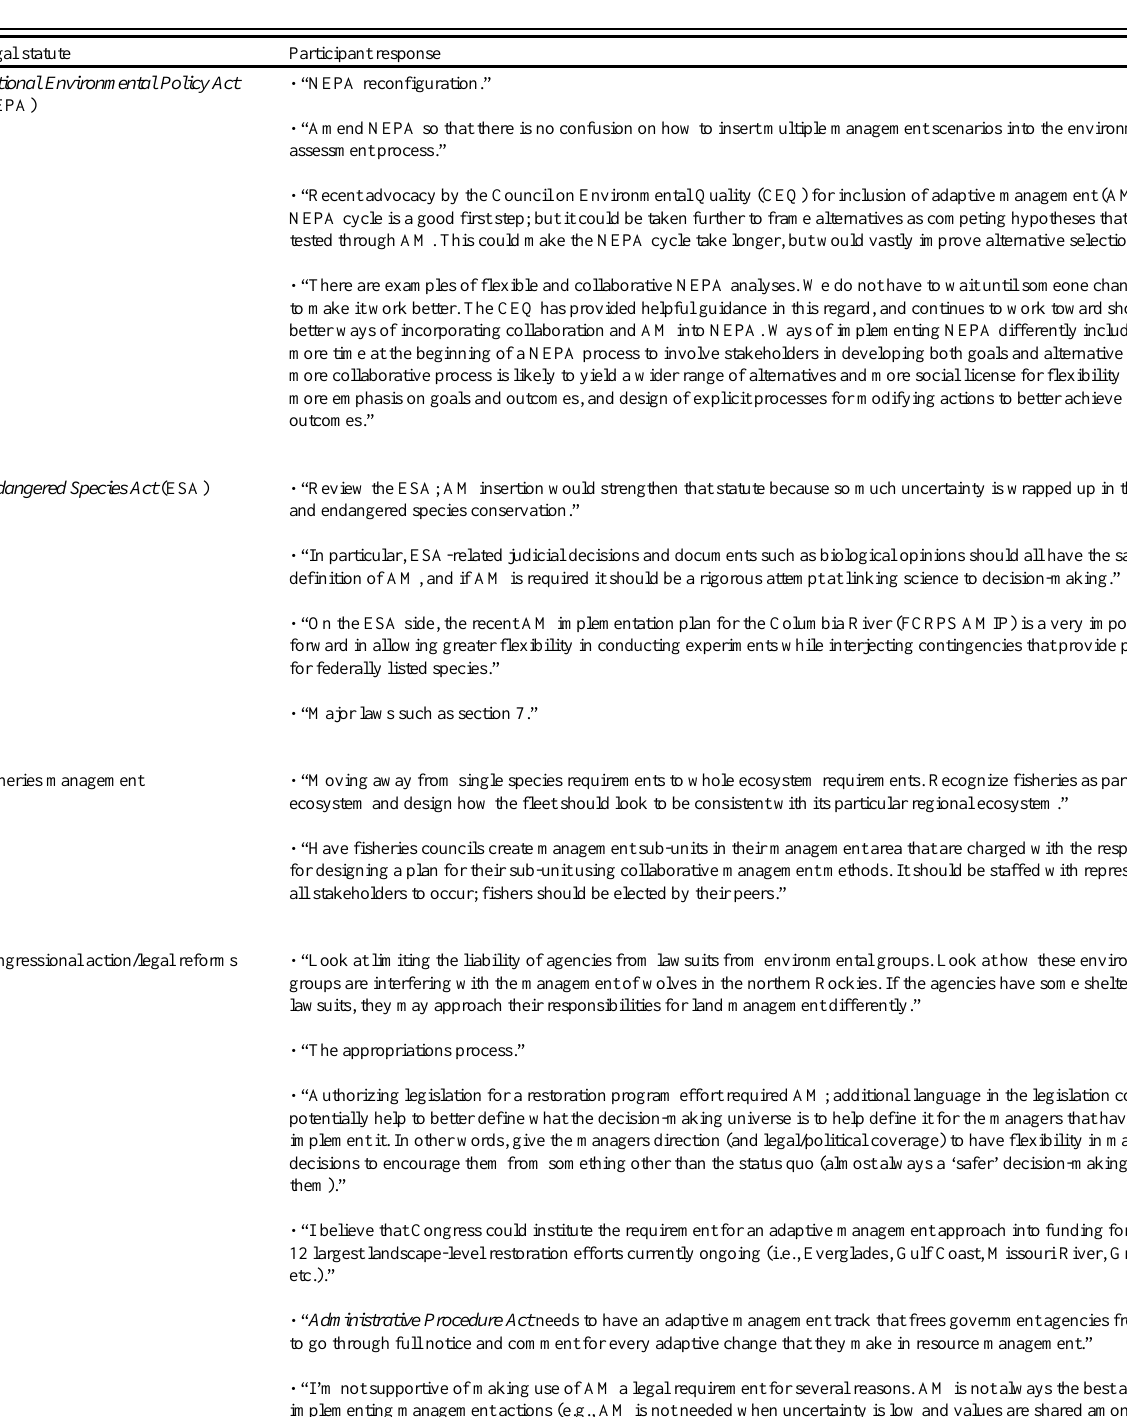
Table 4. Participants’ responses to the question: Can you suggest specific changes to existing legal requirements that would facilitate adaptive